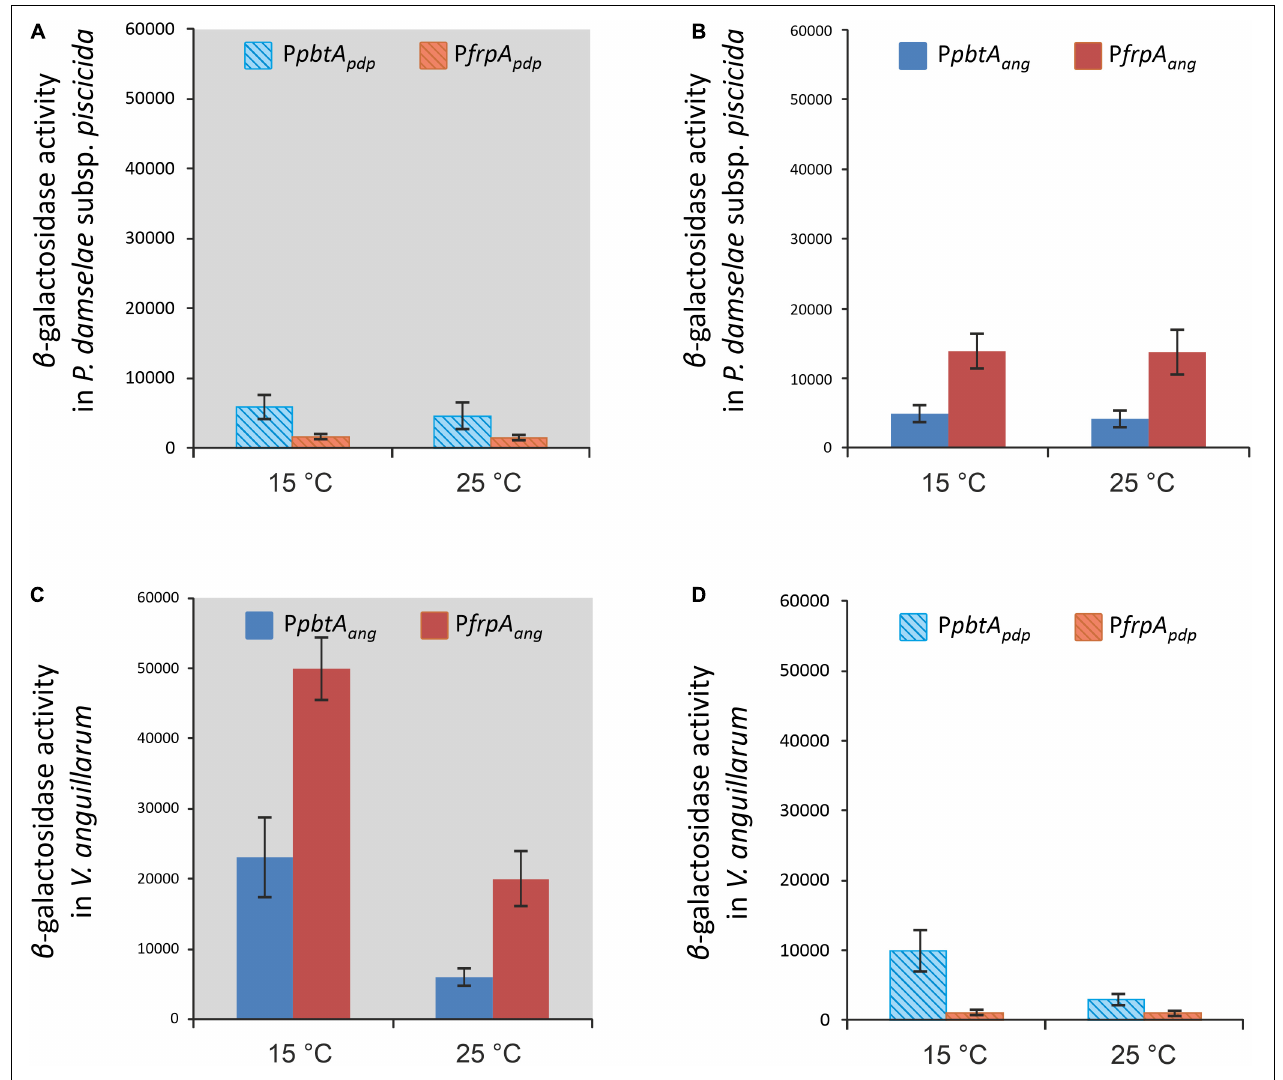
FIGURE 8 | Native ( A,C , gray background) and heterologous (B,D) transcriptional activity evaluation ( β -galactosidase activity) of both versions of the piscibactin promoters P frpA (P frpA pdp or P frpA ang ) and P pbtA (P pbtA pdp or P pbtA ang ) in P. damselae subsp. piscicida (A,B) or in V. anguillarum (C,D) under iron restriction at 15 or 25 ◦